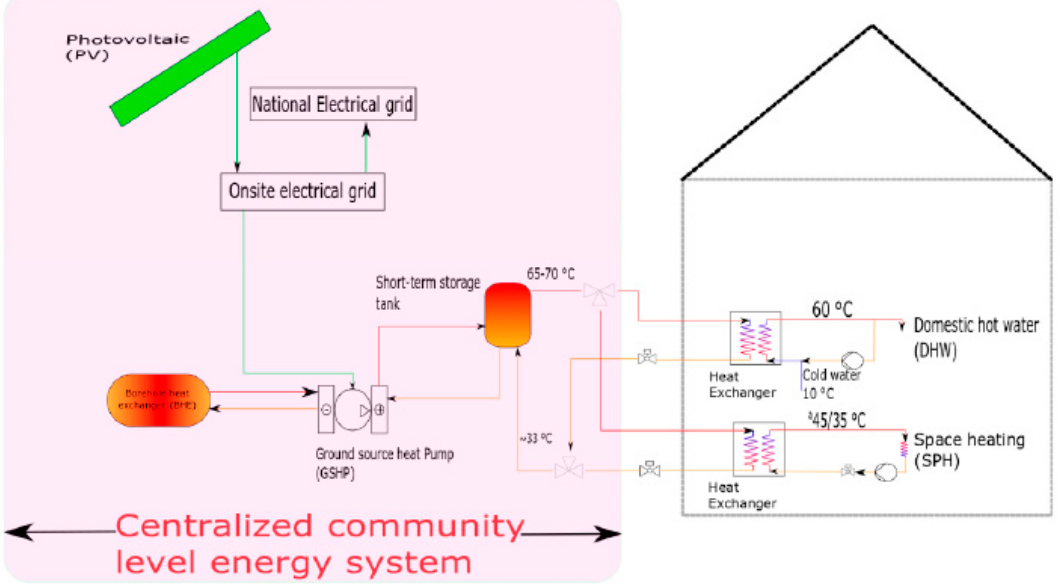
Figure 3. The schematic diagram of the centralized photovoltaic (PV) and ground source heat pump (GSHP)-based community-level district heating system integrated with old residential buildings in the district (Case 1, PV + GSHP).